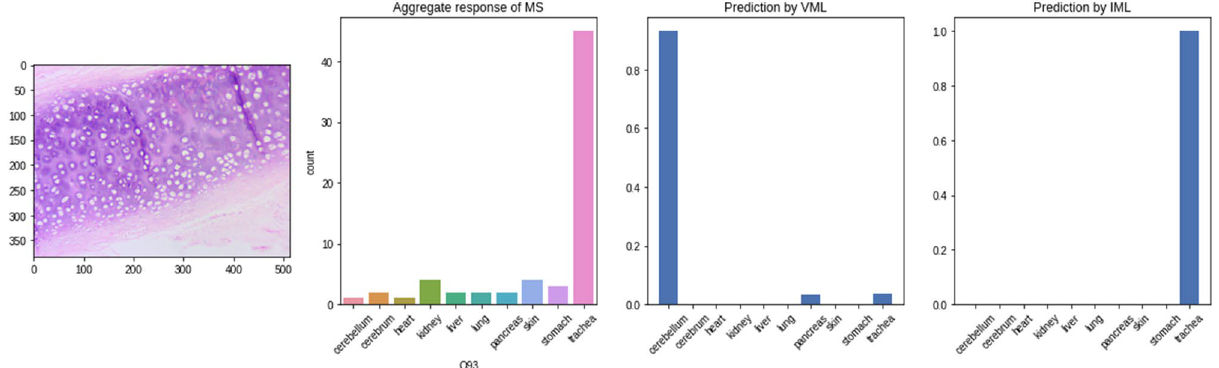
Figure 16. An image of trachea recognised correctly by majority of MS, misclassified by VML and correctly classified by IML (Figure generated by Matplotlib python library, version 3.3.4, https:// matpl otlib. org/).